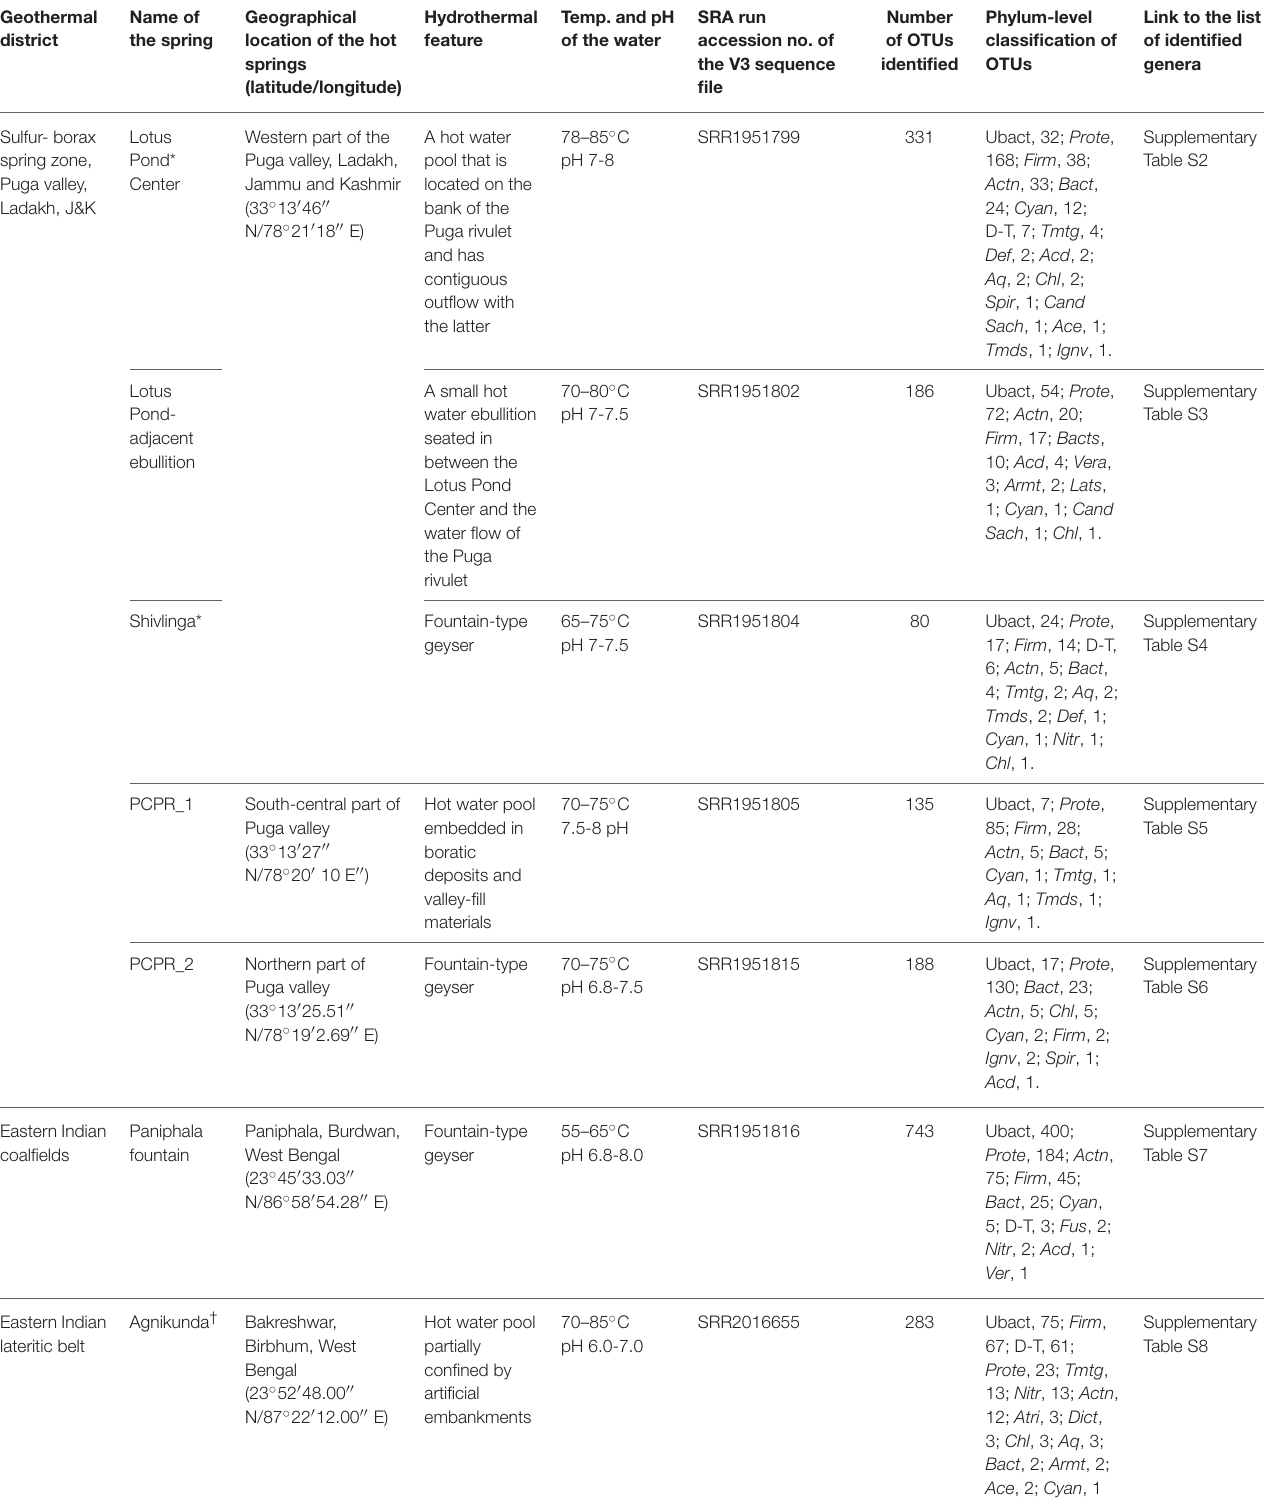
TABLE 1 | Bacterial taxonomic diversity detected in the hot waters of various geothermal vents surveyed in this study. Geothermal Name of district the spring